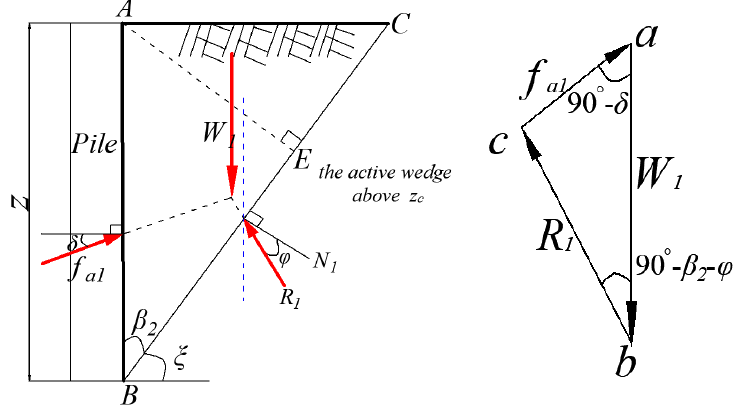
Figure 3. Post-pile active wedge failure mode above critical depth 𝑧 (cid:3030) and the system of forces.